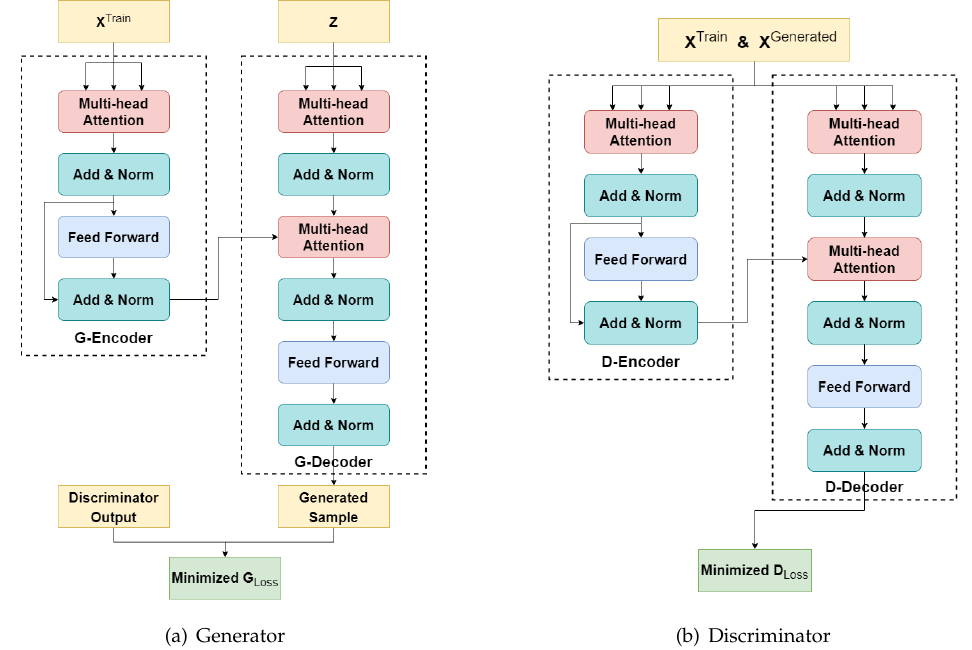
Figure 5. Generator and discriminator of